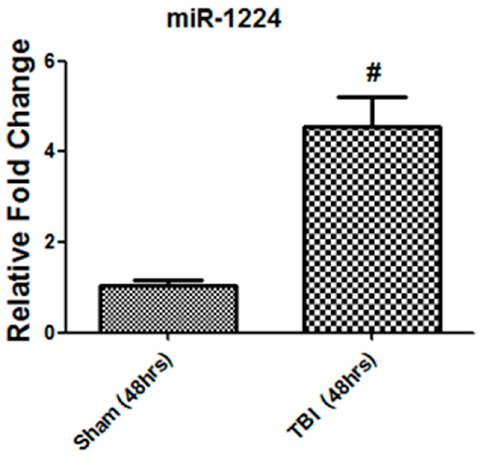
Figure 9. TBI alters the miRNA-1224 content in bone marrow-derived EVs. Real-time PCR showing change in miRNA-1224 expression in 48 h TBI bone marrow-derived EVs cargo ( n = 8, # p < 0.001).